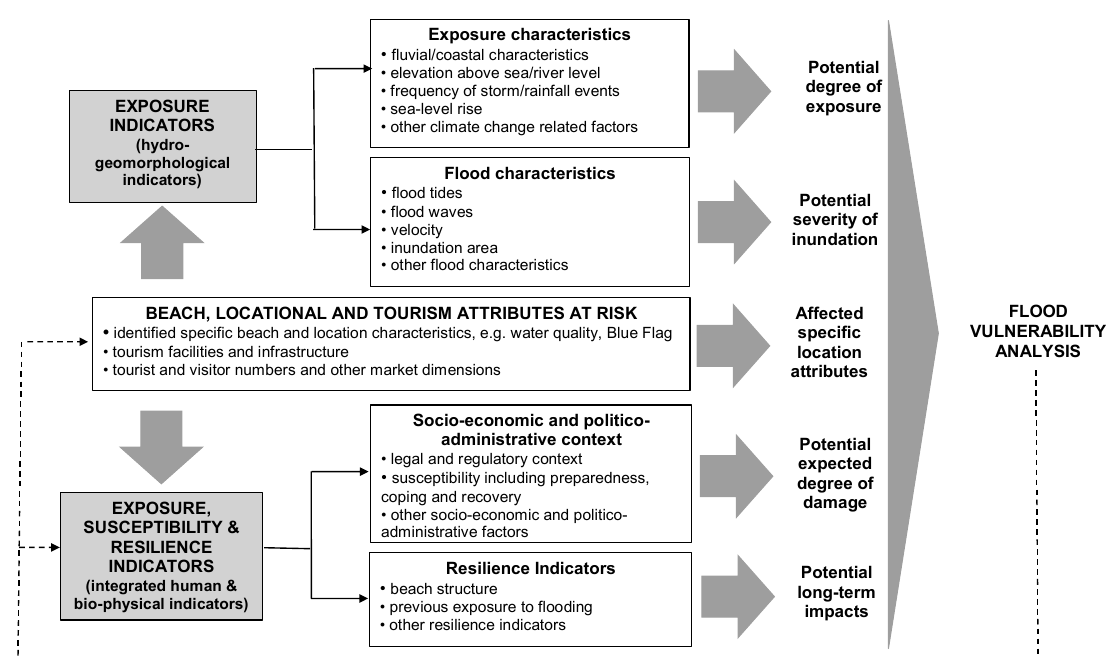
Figure 1. Flood vulnerability analysis for tourism.